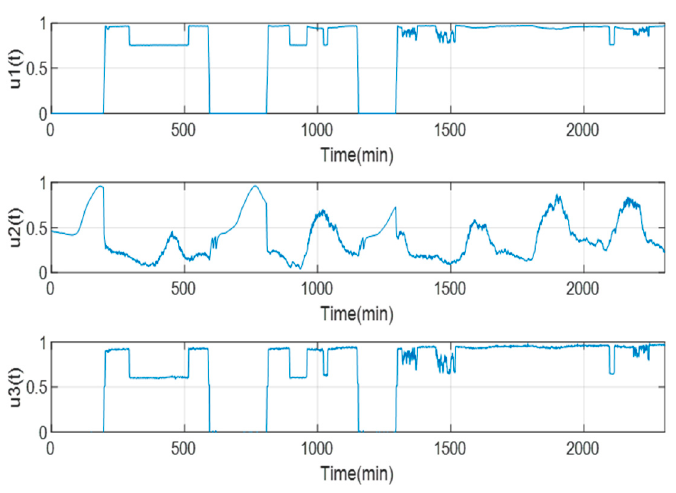
Figure 7. Behavior of the normalized data of the input variables and the output data of the GTL.